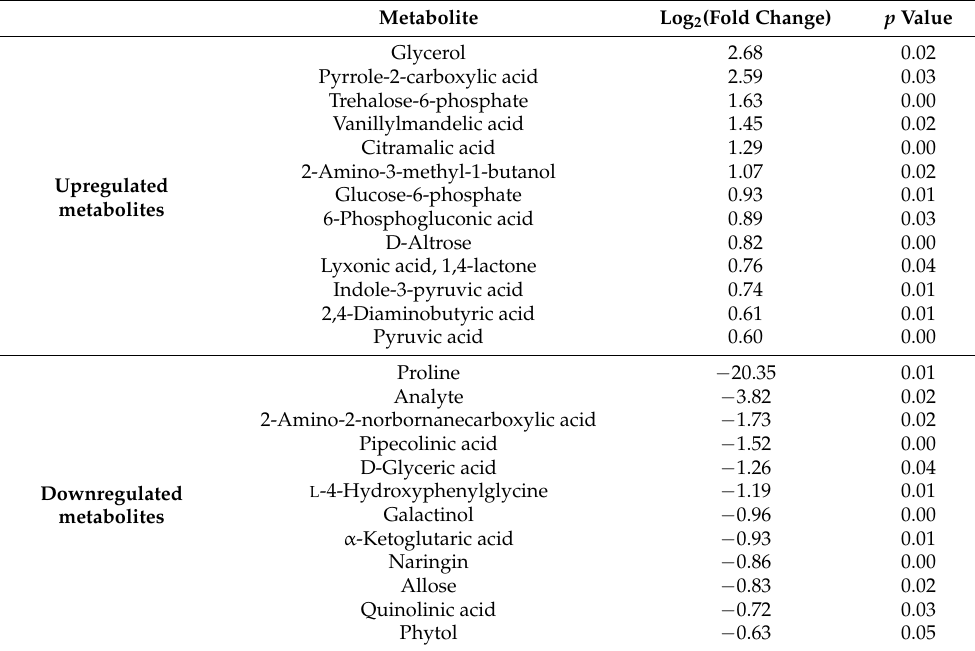
Table 1. Differential metabolites identified by metabolomic analysis a,b .